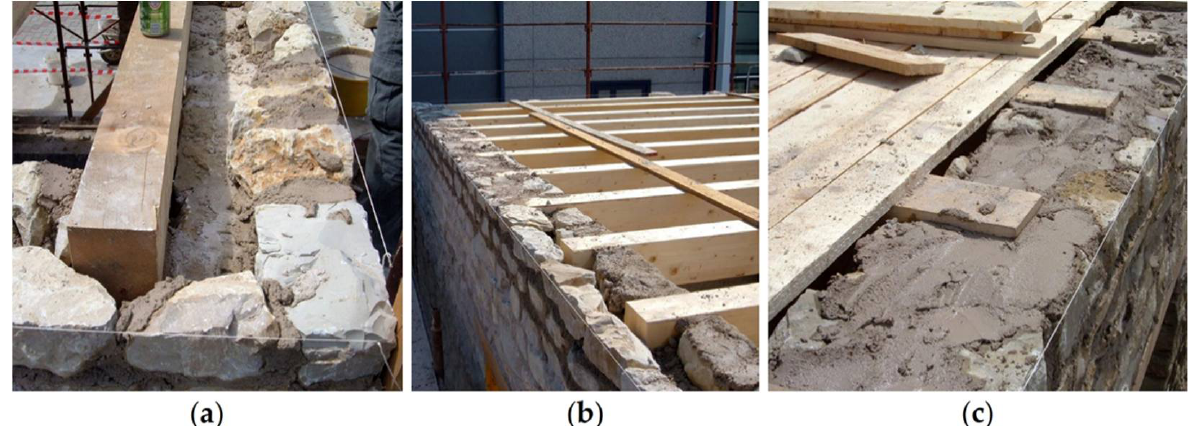
Figure 4. Timber floor: ( a , b ) floor joists supported by the internal wall leaf; ( c ) timber planks nailed to the floor joists. The inclined roof pitches consisted of 8 × 12 cm rafters, resting on spreader beams above the longitudinal walls and extending beyond them by approximately 15 cm, to simulate the roof eaves (Figure 5a,b). The rafters were also supported by a 20 × 32 cm ridge beam. Thin perforated steel plates ensure connection between each pair of rafters matching above the ridge beam (Figure 5c).